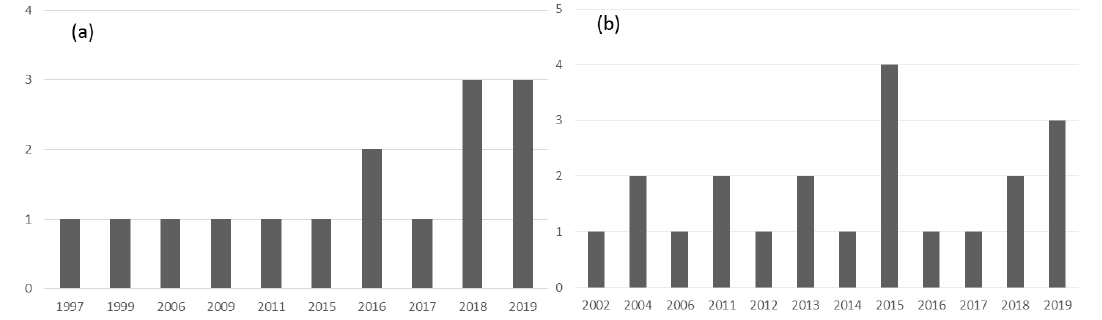
Figure 5. Timeline of published articles on hydrothermal technologies from ( a ) vegetable oils and ( b ) fatty acids.